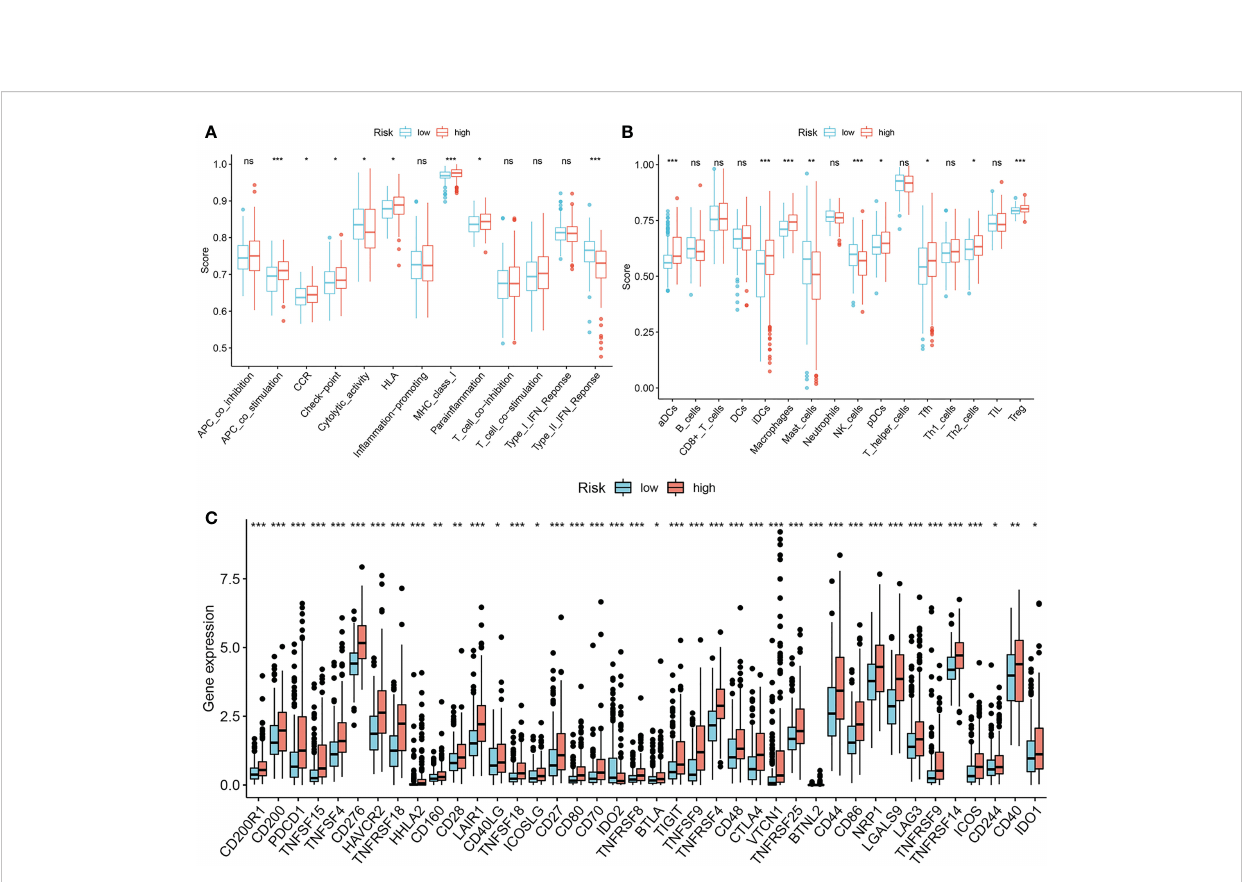
FIGURE 10 Associations between prognostic signature and immune in fi ltrating cells/immune checkpoints. (A, B) single sample Gene Set Enrichment Analysis. (C) Expression pattern of 40 immune checkpoints between the low-risk group and the high-risk group. * P -value < 0.05, ** P -value < 0.01 and *** P -value < 0.001, ns, represents non-signi fi cant.